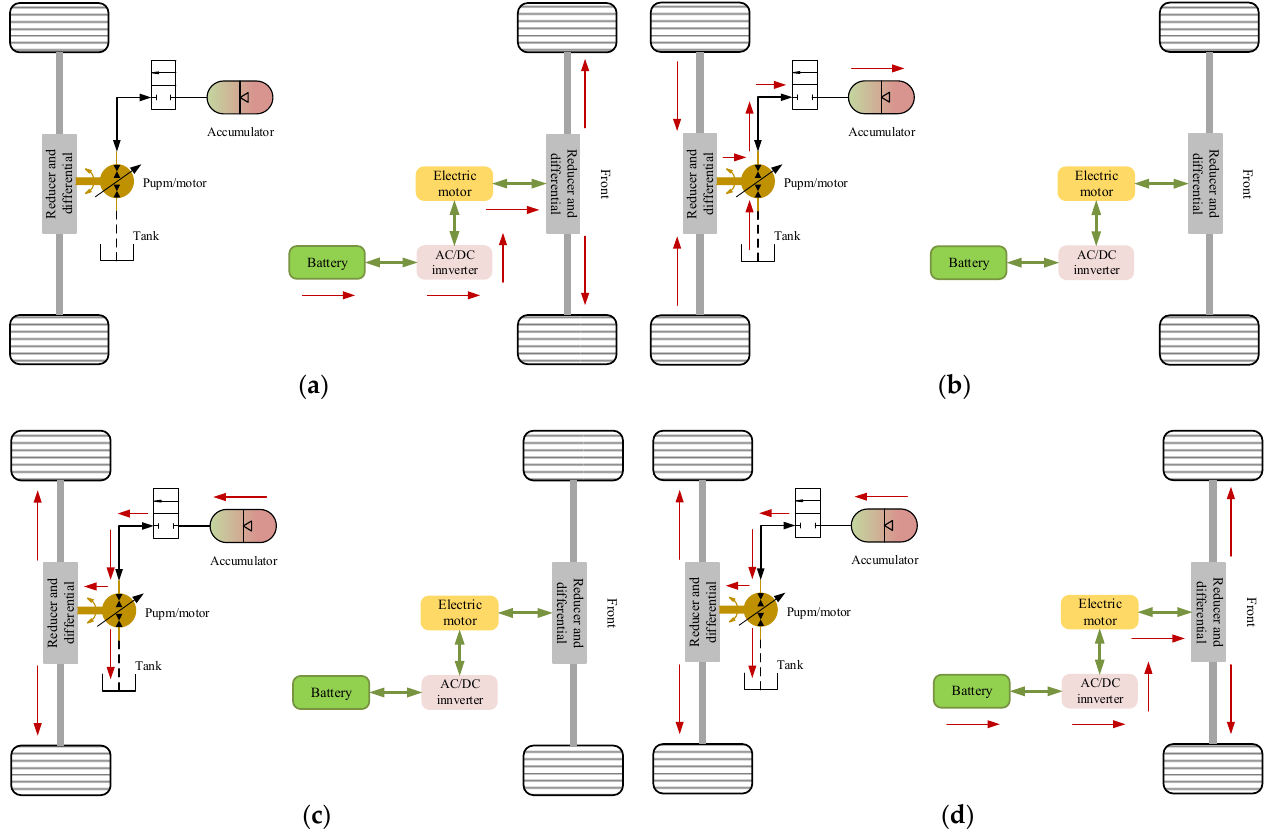
Figure 10. EH2 powertrain operation modes: ( a ) cruising; ( b ) regeneration; ( c ) launch; ( d ) acceleration [86].